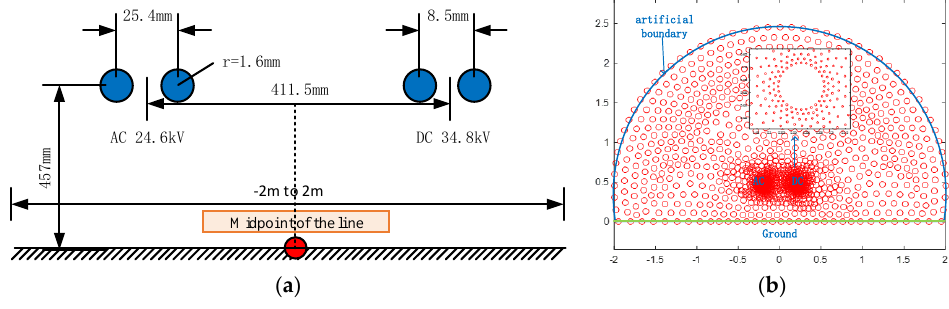
Figure 4. Reduced-scale model. ( a ) Model parameters. ( b ) The calculation node of the MLPG.